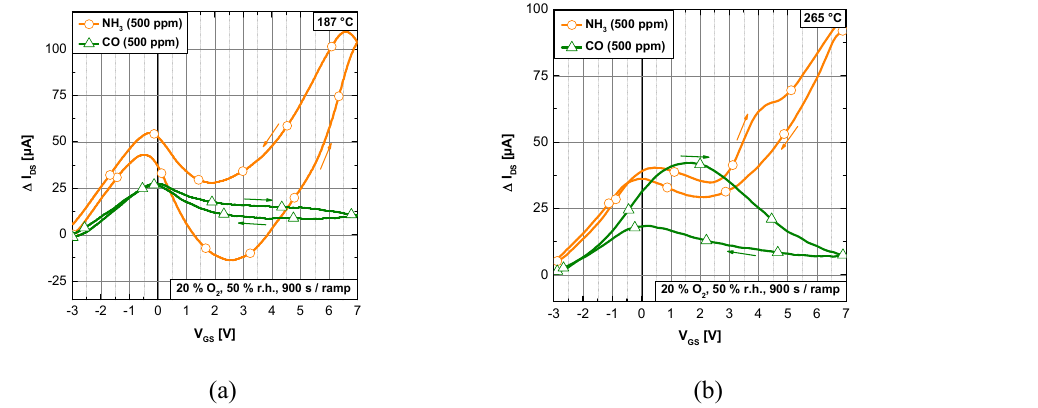
Figure 8. Hysteresis of ∆ I DS for CO (green, triangles) and NH 3 (orange, circles) in humid air (20% O 2 , 50% RH) at 187 ◦ C (a) and 265 ◦ C (b) .